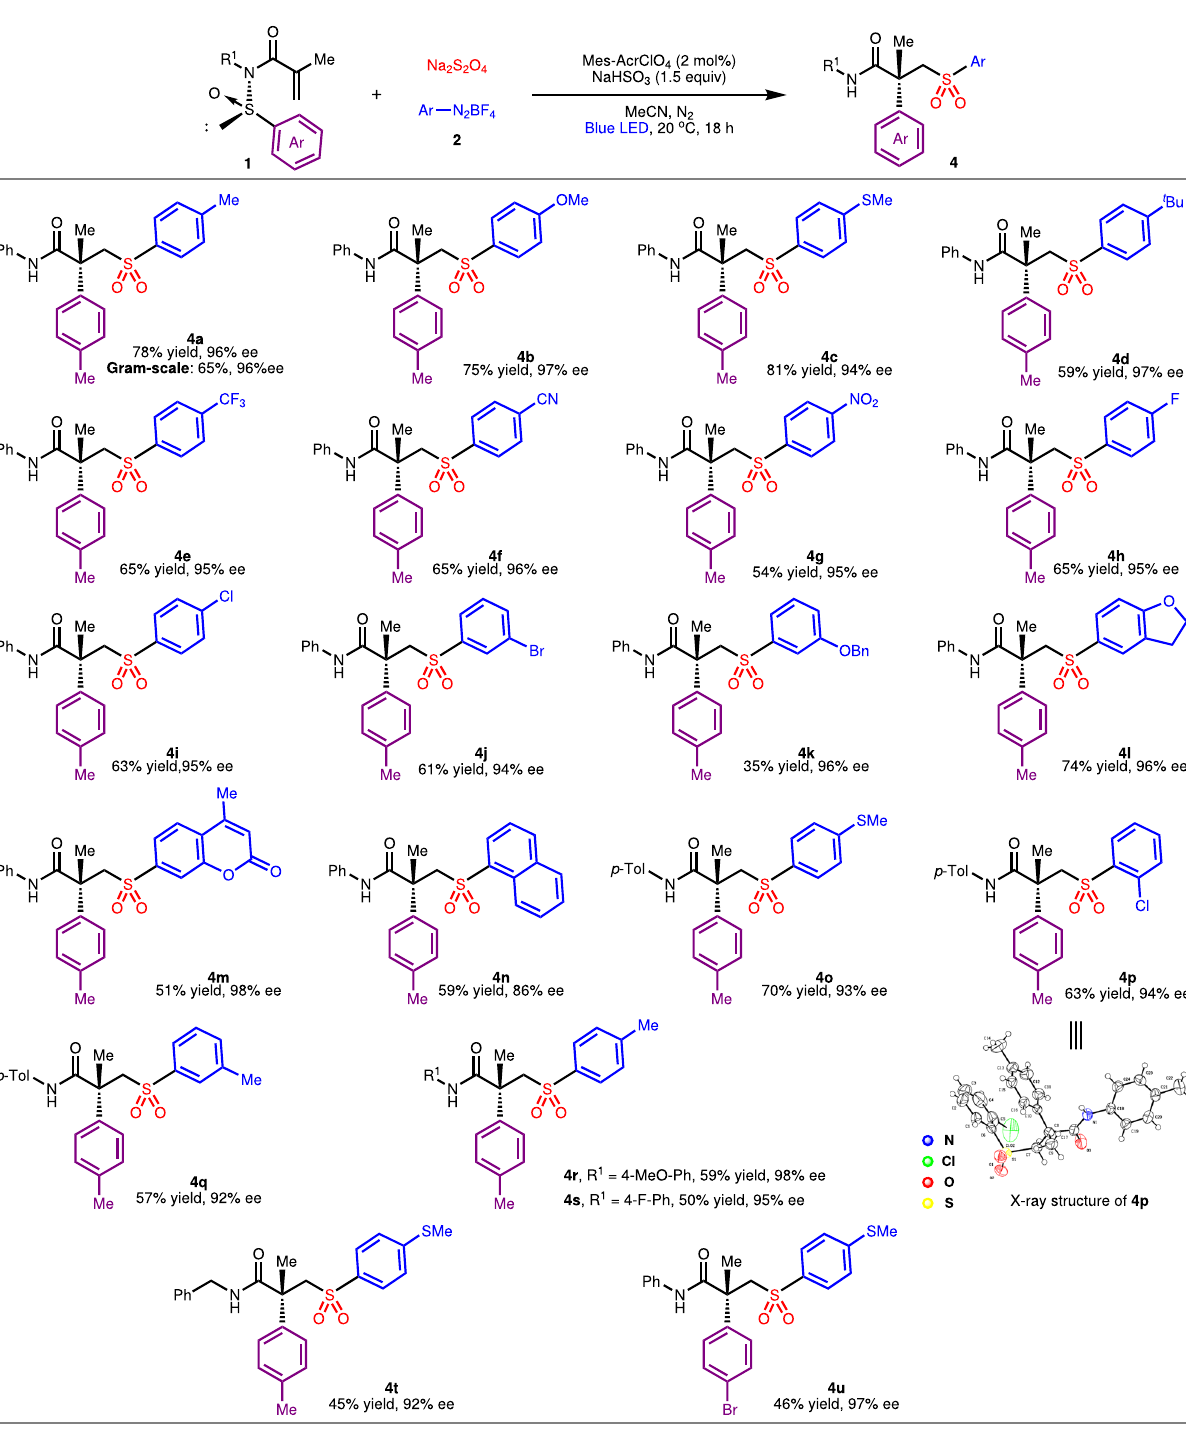
Na 2 S 2 O 4 (0.4mmol), Mes-AcrClO 4 (2mol%), NaHSO 3 (0.3mmol), MeCN (3.0mL), 35W blue LED, under N 2 at 10°C for